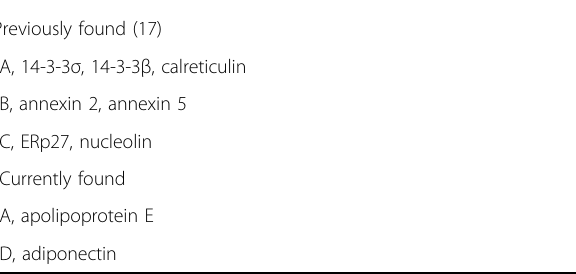
Table 1 CLSP interactors and their CLSP-linked